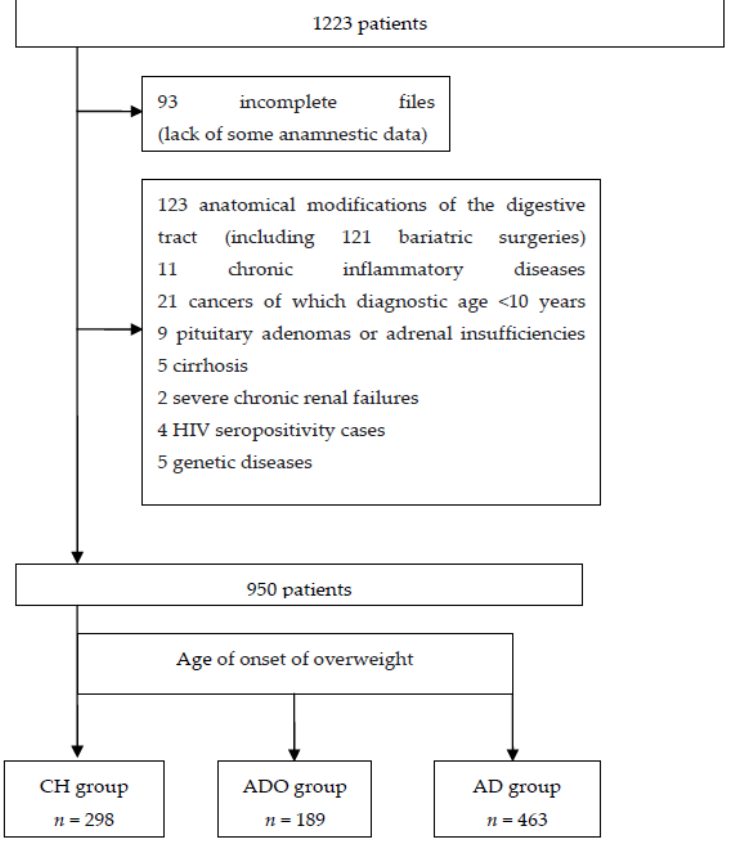
Figure 1. List of patient details.